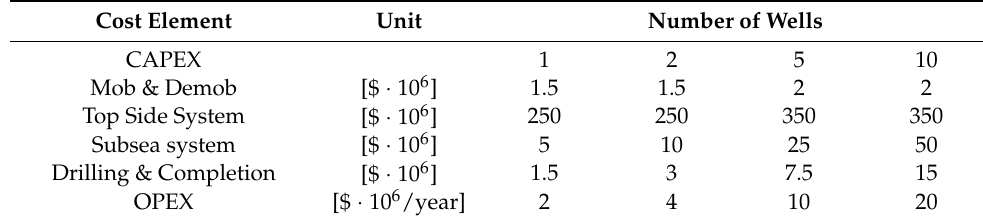
Table 6. Cost data used to compute the simultaneous CO 2 storage and methane production.